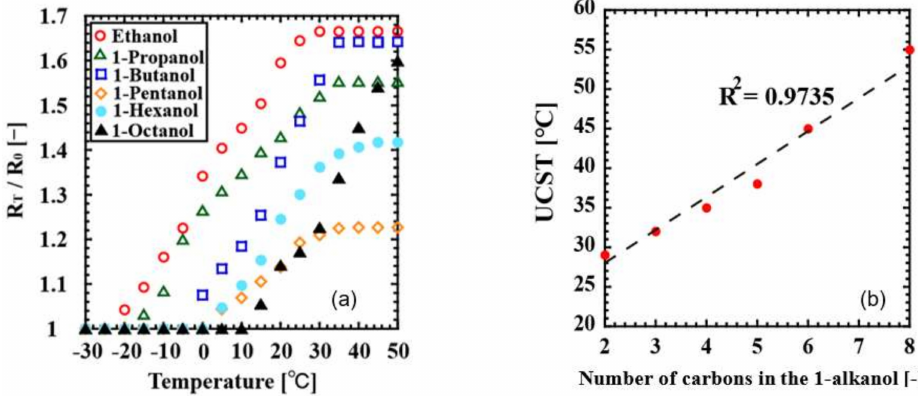
Figure 3. ( a ) UCST-type transition behavior of PTEGA gels in 1-alkanols. ( b ) UCST of the PTEGA gel as a function of the length of the